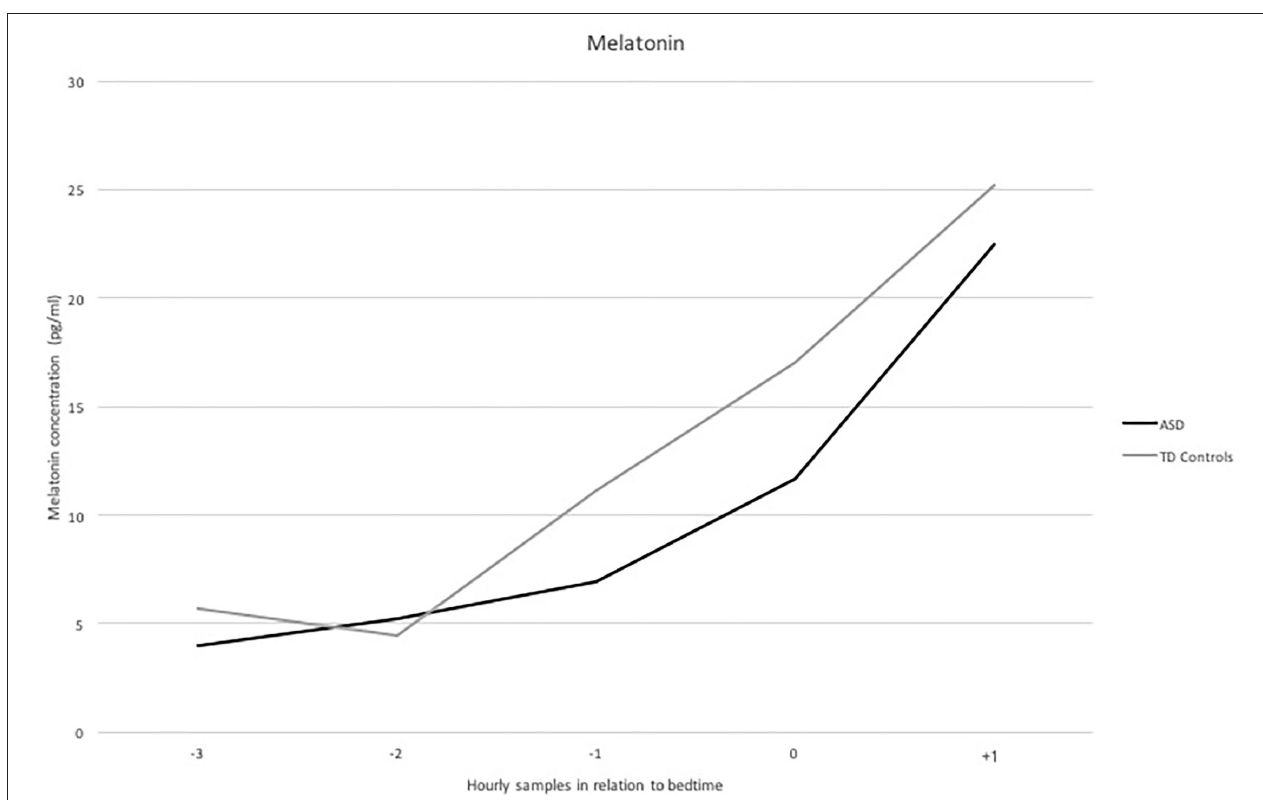
FIGURE 1 | Levels of melatonin (pg/ml) in saliva ( Y axis) for the period studied, i.e., − 3, − 2 and a − 1 hour before bedtime, at bedtime and + 1 hour after bedtime (X axis) in the ASD and control group.